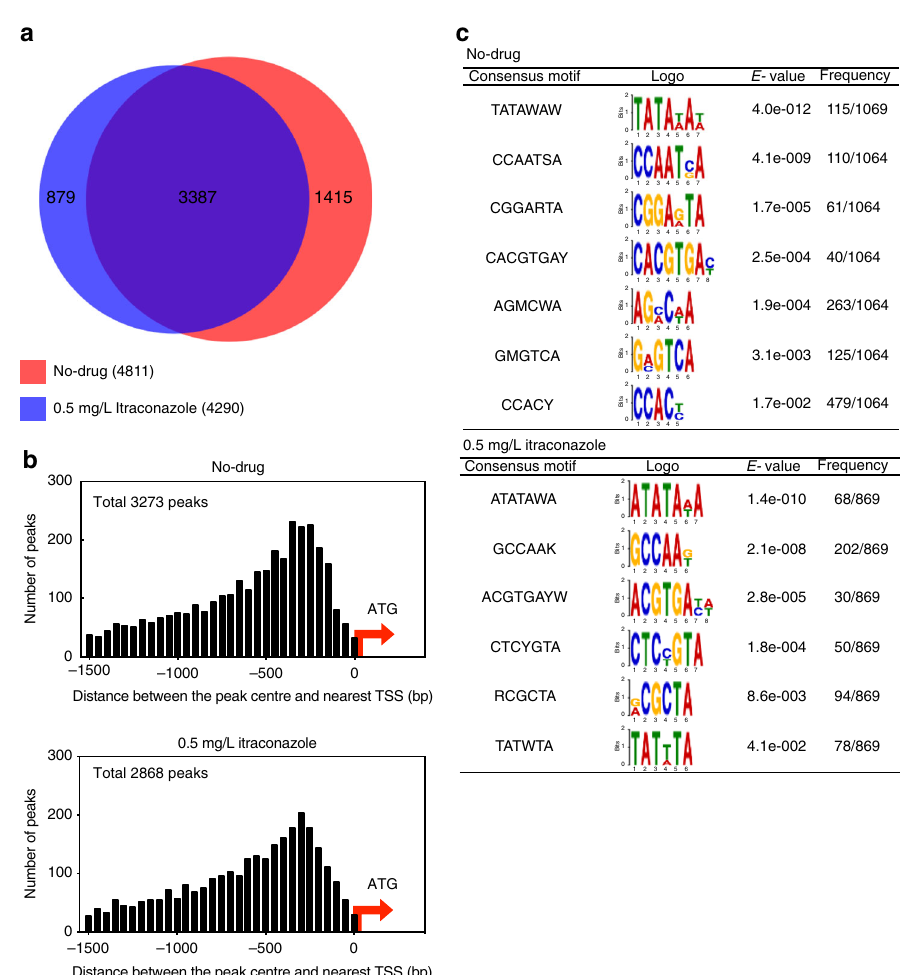
Fig. 4 Genome-wide binding pro fi le of NctA. a Venn diagram showing the overlap of NctA-binding peaks ( q -value < 0.01, fold enrichment >1.5) obtained from no-drug and the 0.5 mg/L itraconazole-treated conditions. b Distribution of the ChIP-seq peak location with respect to annotated genes. The frequency distribution of the distance between the merged peak summit of the signi fi cant binding peak regions ( q -value < 0.01, fold enrichment >1.5) and the translation start site (ATG) of the nearest annotated gene is plotted. c Conserved nucleotide motifs identi fi ed in the NctA ChIP-seq peak regions. A summary of the de novo motif discovery analysis is shown with the identi fi ed consensus motifs and its sequence logos, the calculated e -values, and the frequency of the appearanc e of the motifs within the ChIP-seq peak set are analysed. Source data are provided as a Source Data fi